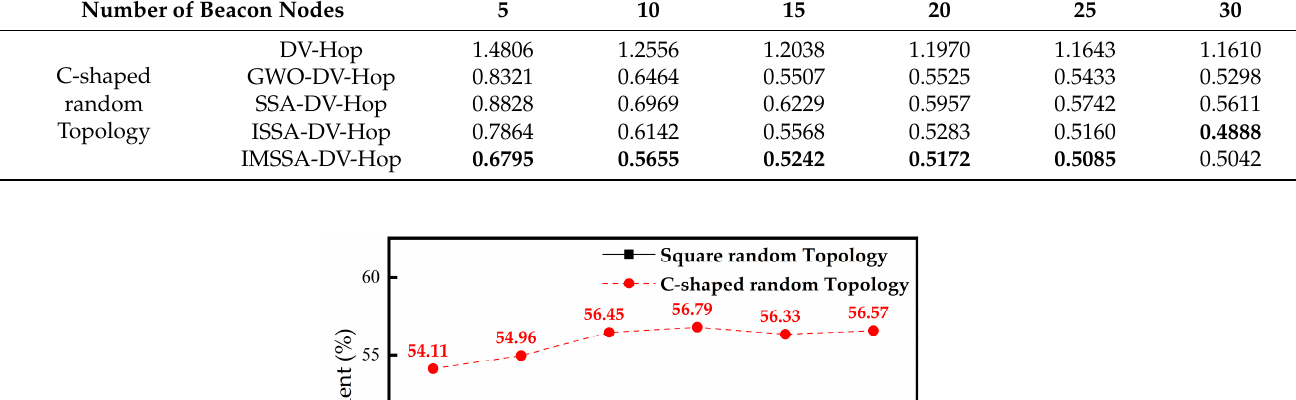
17 of 22 Figure 8. Localization error diagrams for di ff erent number of anchor nodes: ( a ) square random topology; ( b ) C-shaped random topology. From Figure 8a,b, it can be seen that the IMSSA-DV-Hop algorithm in two random topologies can achieve lower localization error compared with the three algorithms com- pared in the case of fewer beacon nodes. In the C-shaped random topology, the perfor- mance of this algorithm is close to that of the ISSA-DV-Hop algorithm when the numbers of beacon nodes are large. The speci fi c experimental data are shown in Tables 6 and 7. The bolded data in Table are the optimal localization error values.